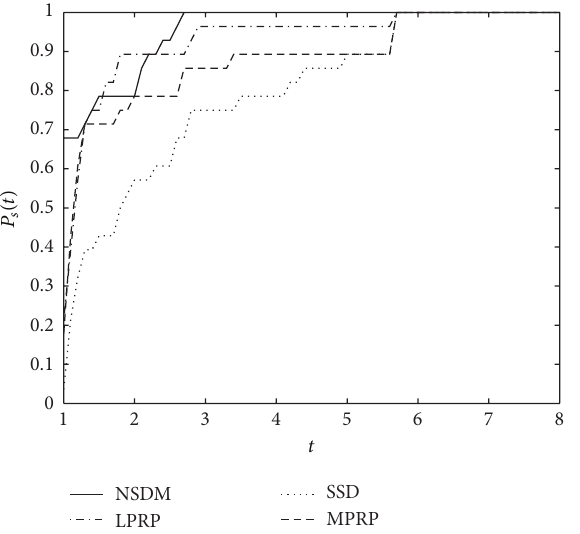
Figure 1: Performance profiles about the number of iterations.